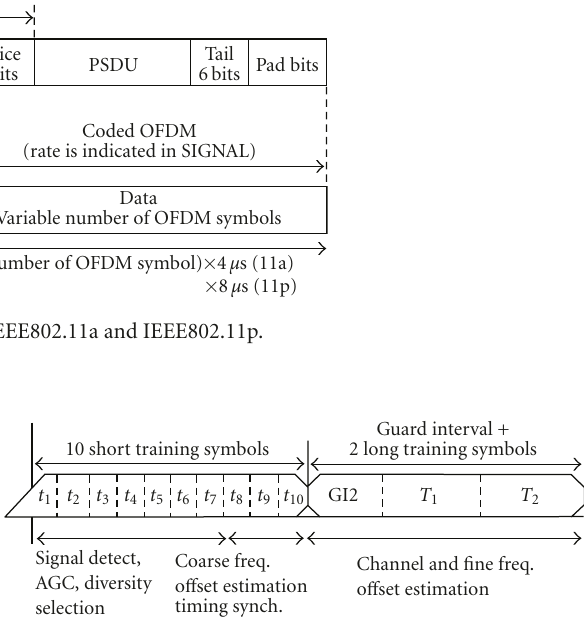
Figure 3: Preamble structure of IEEE802.11a and IEEE802.11p standardization